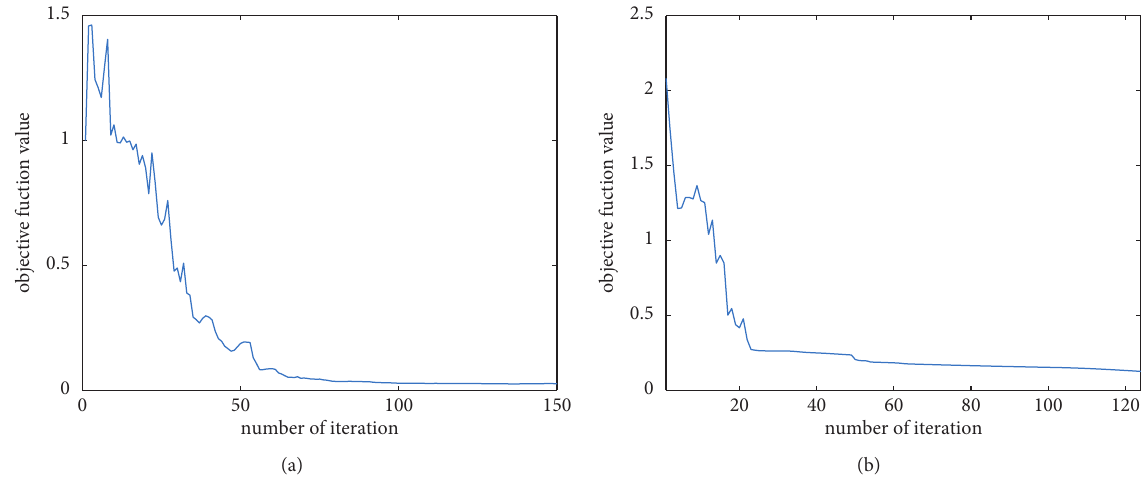
Figure 9: Convergence curve of the proposed algorithm on (a) COIL100 and (b) ORL corrupted with 6 × 6 block